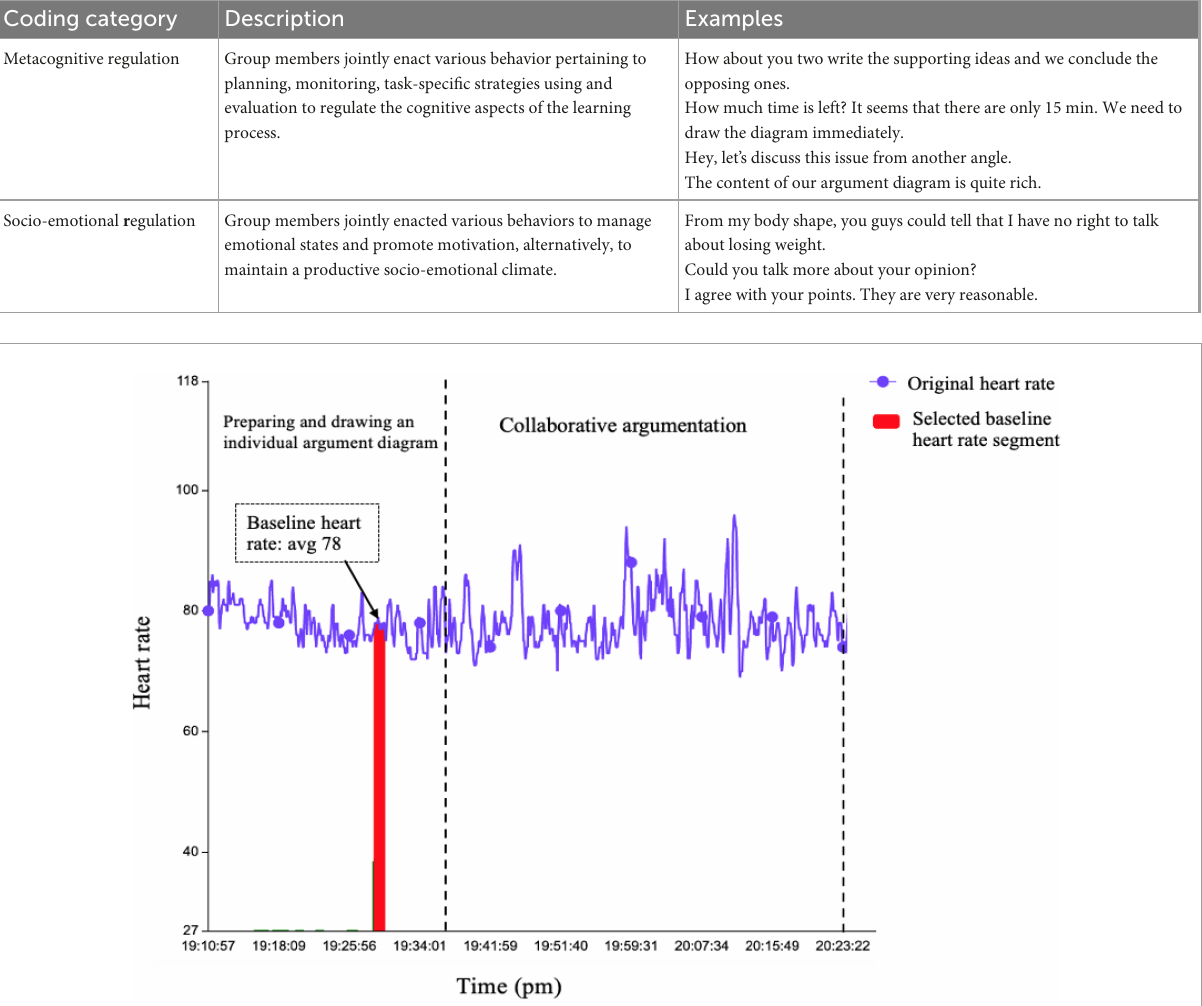
FIGURE3 Computing individual student’s baseline heart rate (HR) [from 19:10:57 to 19:36:52 p.m., one student in group 4 was at the first stage as reading material and drawing the individual argument diagram, and from 19:36:52 to 20:23:22 p.m., she engaged in collaborative argumentation (CA). The baseline HR is 78, the average score of the selected baseline HR